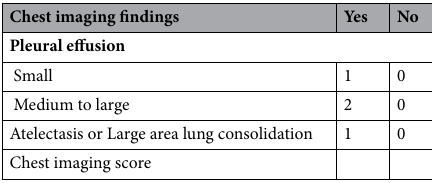
Table 3. Chest imaging score.